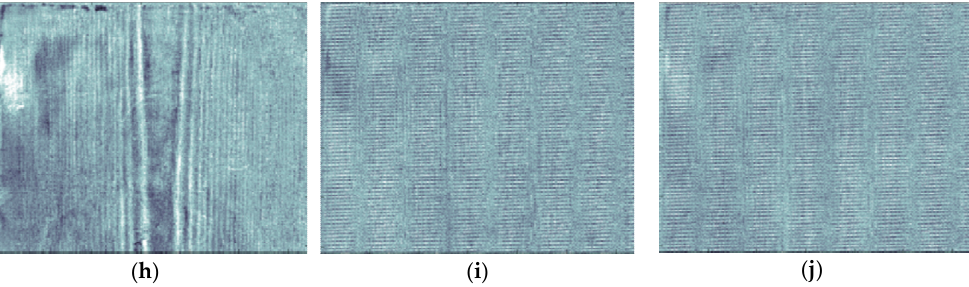
Figure 5. Examples of principal components (PCs) extracted: ( a ) General view of the inspected object; ( b ) PC1; ( c ) PC2; ( d ) PC3; ( e ) PC4; ( f ) PC5; ( g ) PC6; ( h ) PC7; ( i ) PC8; ( j ) PC9.